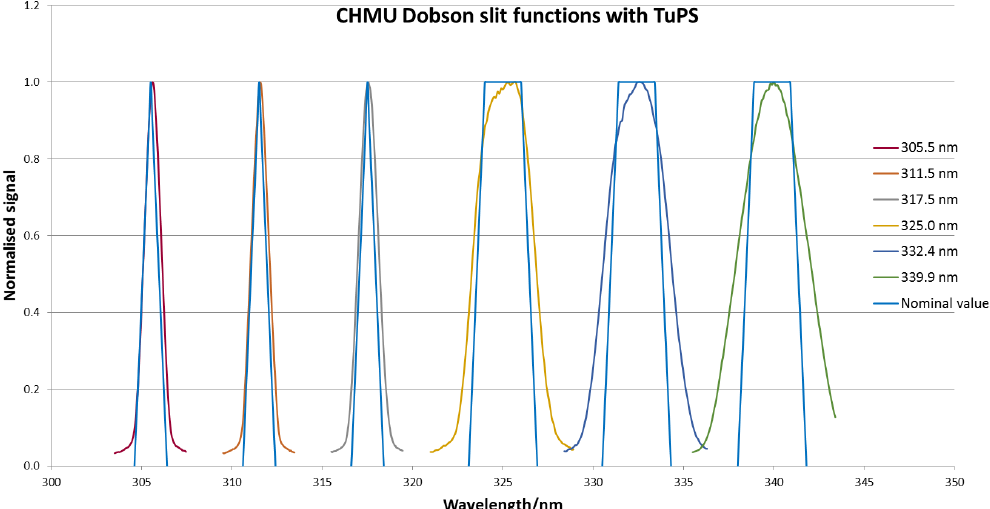
Figure 9. Dobson #074 slit functions measured during the TuPS-based in-field characterisation. Table 1. Results of the TuPS-based in-field characterisation of Dobson #074. Peak nominal